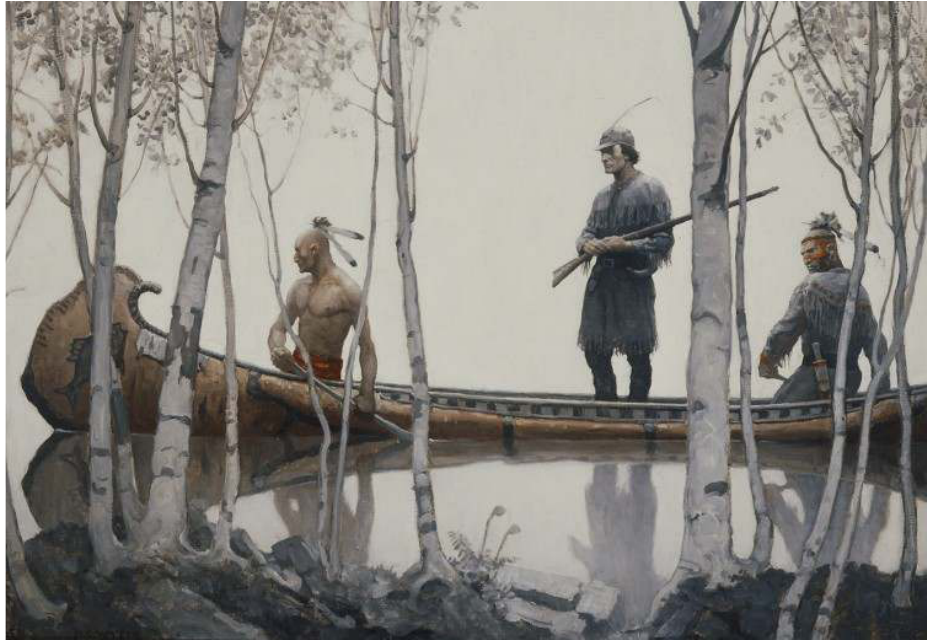
Figure 8. N. C. Wyeth, endpaper illustration of The Last of the Mohicans. Oil on canvas